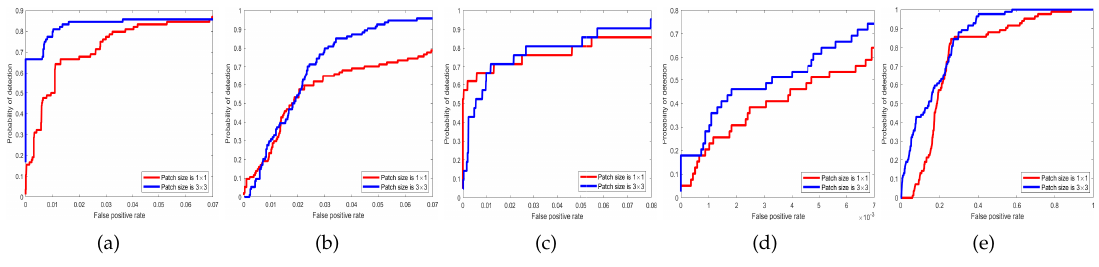
Figure 26. Without patch-based and patch-based ROC curves. ( a ) Synthetic Dataset, ( b ) San Diego